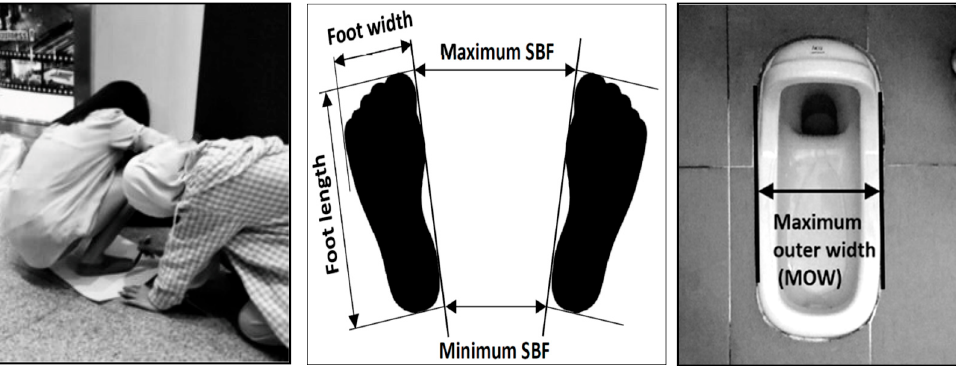
Figure 1. Measurements of the span between feet (SBF) and maximum outer width (MOW) of public squat toilets.